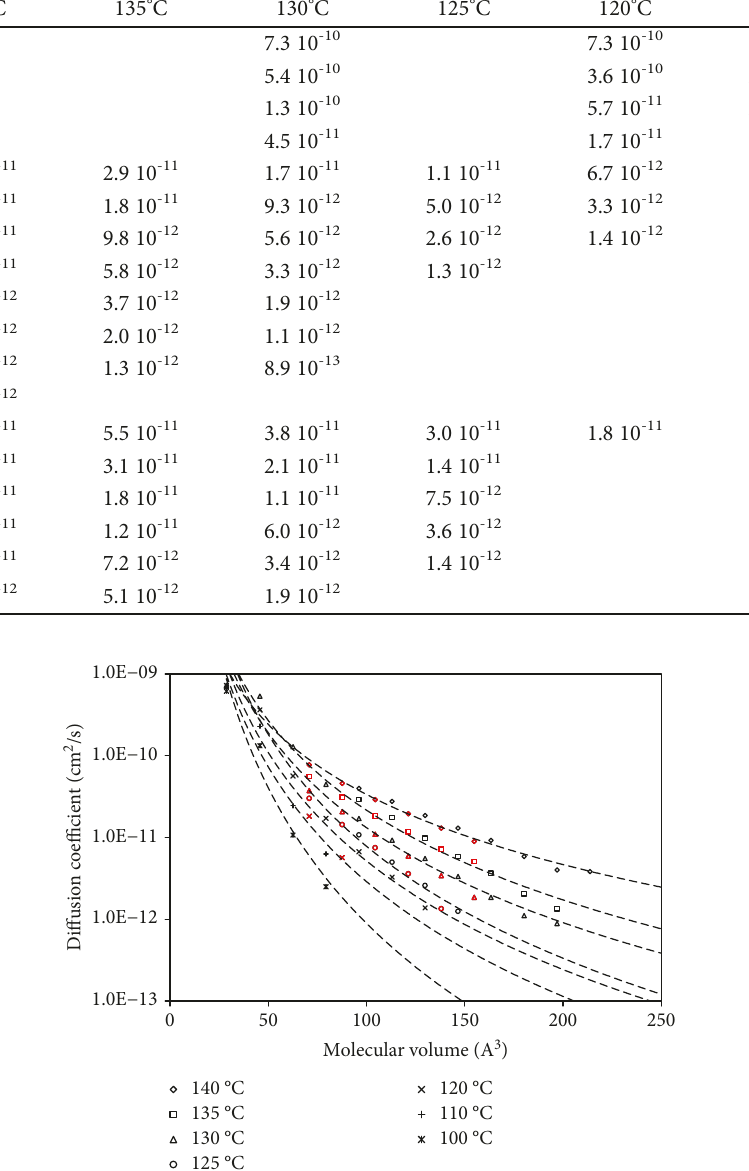
Table 2: Experimentally determined di ff usion coe ffi cients D